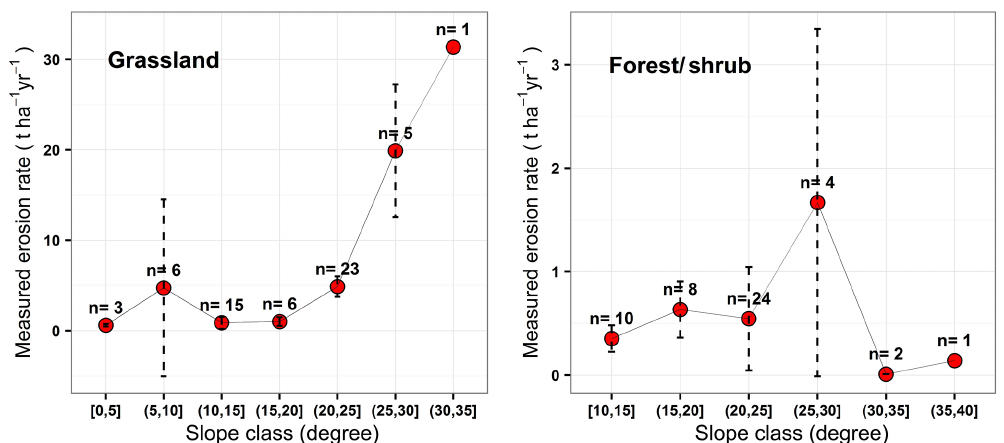
Figure 4. Weighted mean soil erosion rate under grassland and permanent vegetation (PV) for different slope classes: erosion rates were calculated using the data from our erosion plot database. Slope does not have a statistically significant effect on topsoil erosion rates on land under permanent woody vegetation. On grassland, a slope effect may be present, but only for slopes exceeding 25 ◦ : however, more data are needed to confirm this. Table 1. Correlation (Pearson r 2 ) between topsoil erosion rate and topography (slope gradient and slope length) under different land uses: no significant relationships were found for plots with a permanent vegetation cover. The effect of slope is significant on grassland but this is due to high values observed on slopes exceeding 25 ◦ , for which only a few data points are available: no significant slope effect is present for lower slope gradients (Fig. 4). Bare Fallow Farmland Grassland Vegetation cover ( n = 14) ( n = 16) ( n = 120) ( n = 90) ( n = 66) Slope degree 0.64 ∗ 0.84 ∗∗∗ 0.49 ∗∗∗ 0.19 ∗ ns Slope length ns